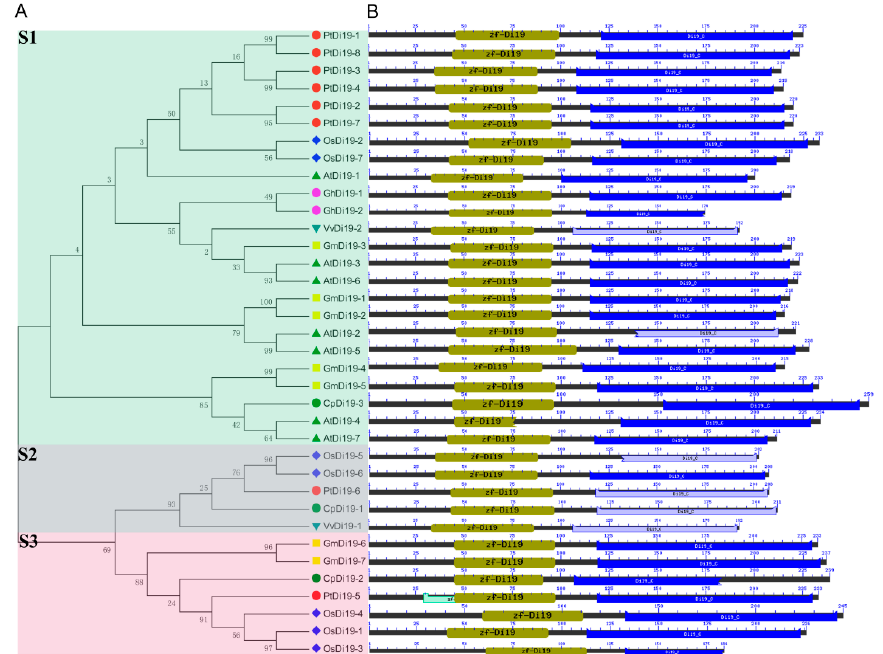
Figure 1. Phylogenetic tree and conserved protein structure of Di19s in seven species. ( A ) The phylogenetic tree constructed by the neighbor-joining method implemented by MEGA software. Different colors represent different subfamilies; Di19-S1/-S2/-S3 subfamilies use green, blue, and red, respectively. ( B ) Conserved protein domain analysis of Di19s. The amino acid length, zf-Di19 domain, and Di19_C domain are represented by black, olive green, and blue, respectively. The length of each pattern is displayed proportionally.